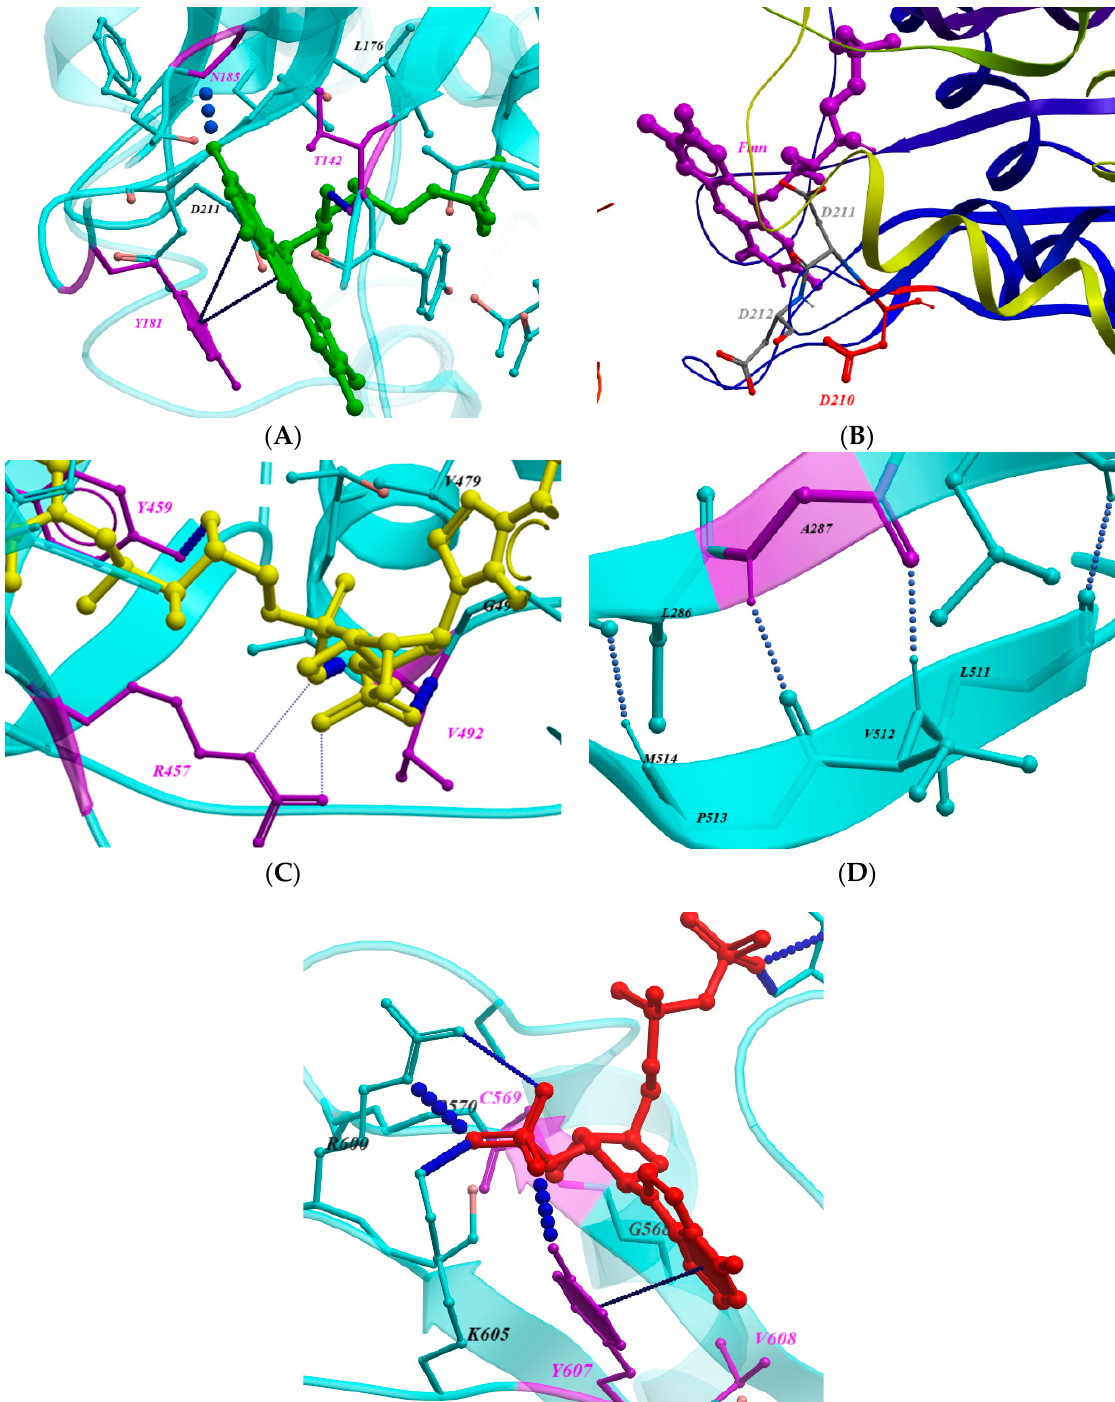
Figure 7. An in silico view of POR cofactor binding domains and location of the conserved amino acid residues. ( A , B ) The Y181 and D210 interactions with the FMN cofactor and neighboring residues within the FMN binding domain, respectively. ( C ) The R457 interactions with the FAD cofactor and neighboring residues within the FAD binding domain. ( D ) The A287P interactions with the neighboring residues below the FAD binding domain. ( E ) The Y607 interactions with the NADPH cofactor and neighboring residues within the NADPH binding domain.